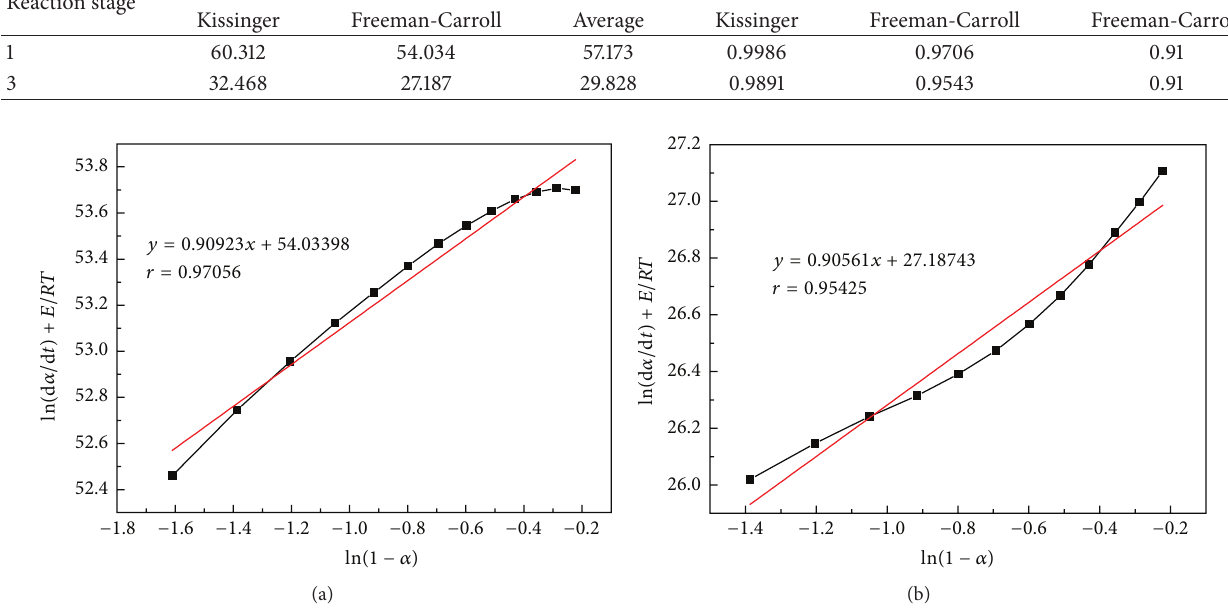
the third mass loss stages. The reaction order can be found out through the slope of the line, and the preexponential factor 𝐴 can be gotten by the intercept. The results are displayed in Table 4. The kinetic equation for the thermal